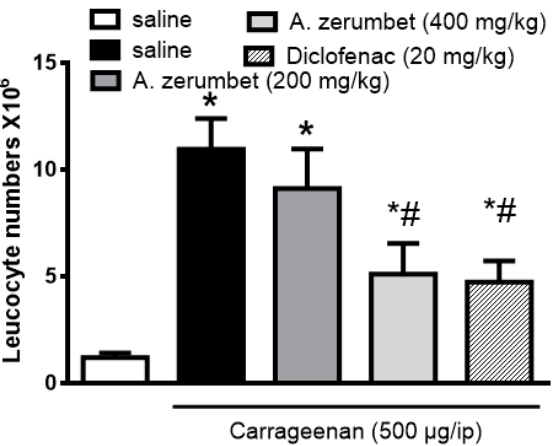
Figure 6. Effect of A. zerumbet extract in a dose of 200 and 400 mg/kg, p.o or diclofenac (20 mg/kg, p.o.) administration one hour before carrageenan injection (500 μ g, i.p.) on leukocyte migration into the peritoneal cavity of mice (total number × 10 6 ). Data is presented as mean ± S.E.M. (n = 5–6). * p < 0.01 vs. vehicle (saline) values, # p <0.01 vs. control (carrageenan treated group).